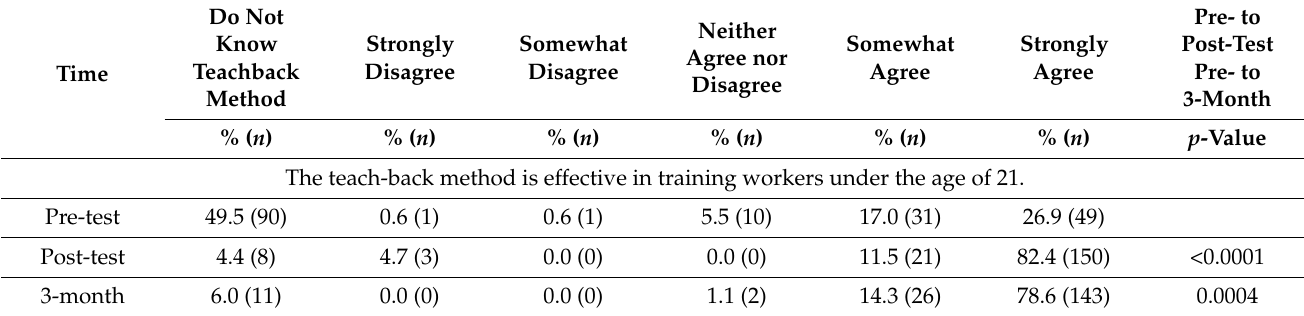
Table 5. Changes in supervisor beliefs about teach-back method effectiveness and importance over